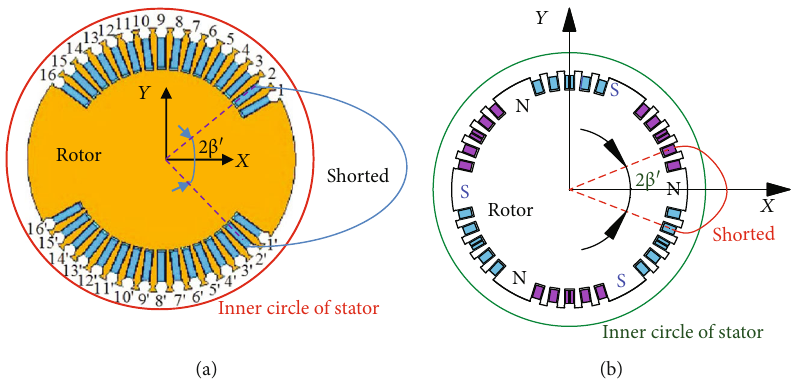
Figure 1: RISC: (a) QFSN-600-2YHG turbine generator ( p = 1 ) and (b) MJF-30-6 prototype generator ( p = 3